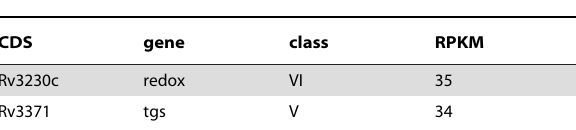
Table 4. Ranking of the most abundant coding transcripts in stationary phase.